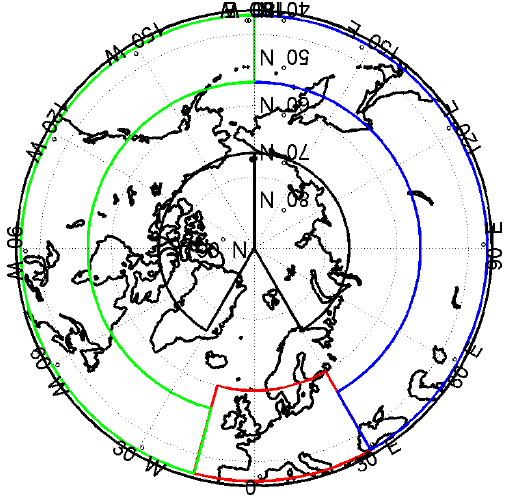
Figure 4. Map of the regions selected to study the origin of the air masses in the FLEXPART analysis. The red, green and blue boxes correspond to our definition of the European, North American and Eurasian regions. The two black boxes are called western and east- ern Arctic